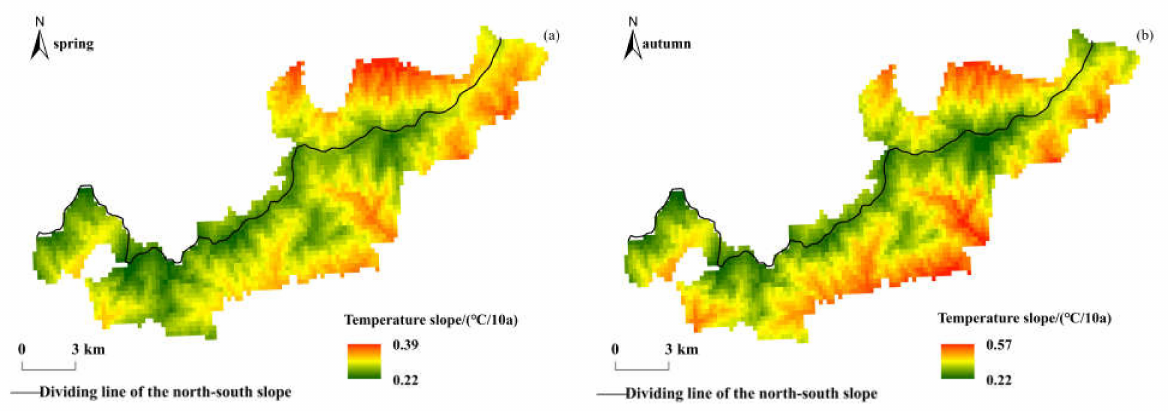
Figure 10. Spatial distribution of interannual change trends of temperature in Niubeiliang Reserve from 1985 to 2017. ( a ) Slope of temperature in spring. ( b ) Slope of temperature in